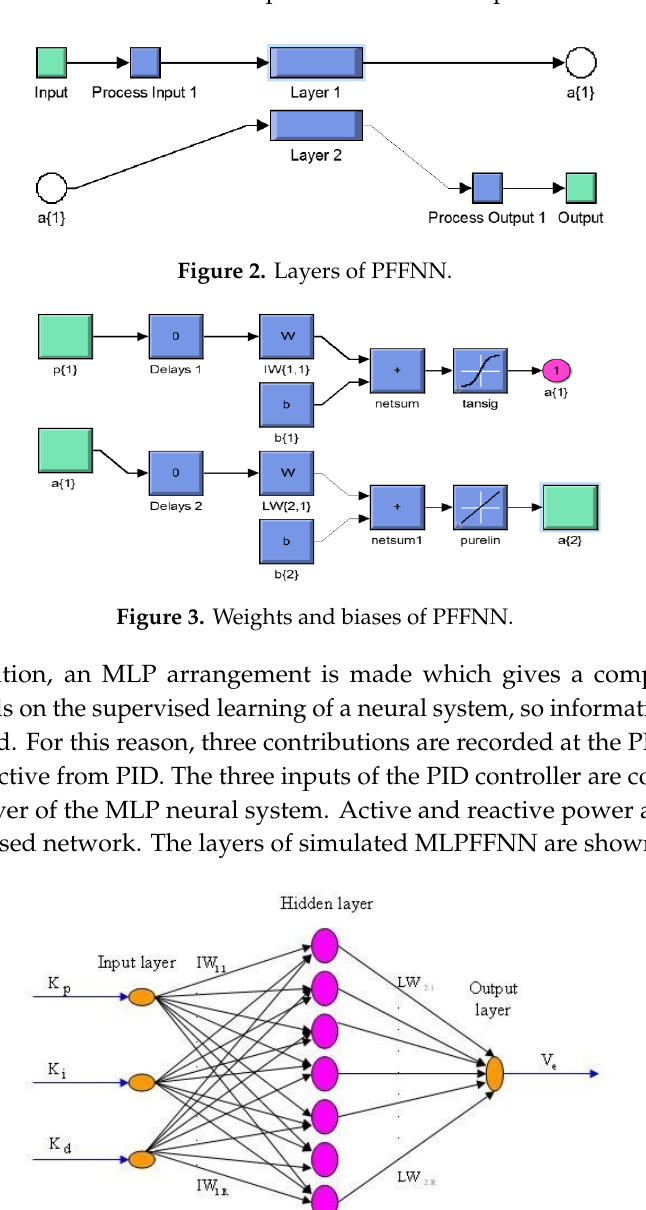
Figure 4. Layers of MLPFFNN.